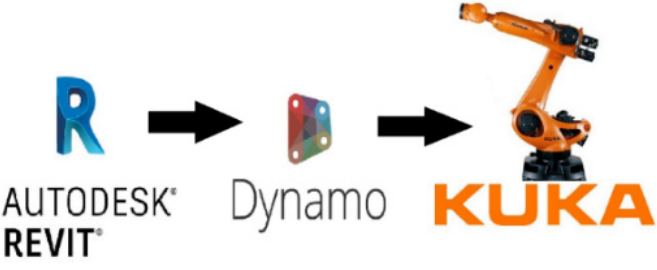
Figure 4. Communication Revit TM , Dynamo TM , and KUKA TM .